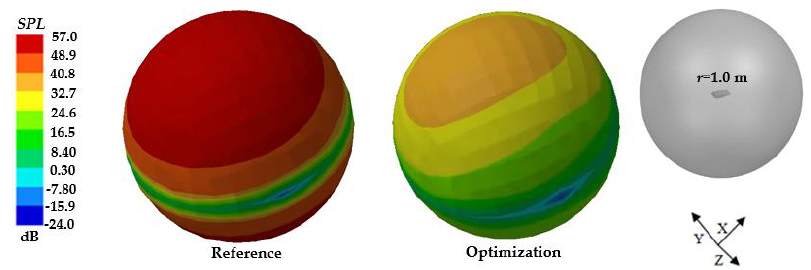
Figure 16. Comparison of the sound field distribution.